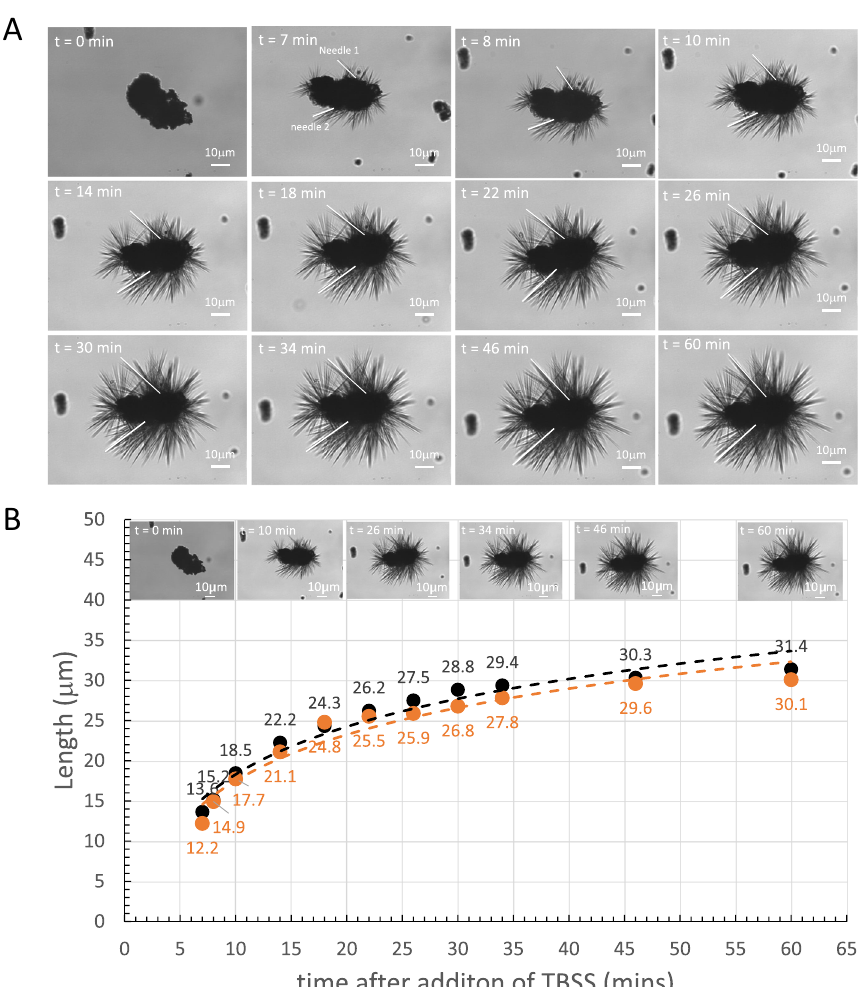
Fig. 19 A Yomesan in pH 9.34 TBSS: Development of new needle growth vs time under static conditions (0–60 min). B Needle growth from Yomesan-niclosamide in pH 9.34 Tris-buffered saline: length (mm) vs time after addition of TBSS